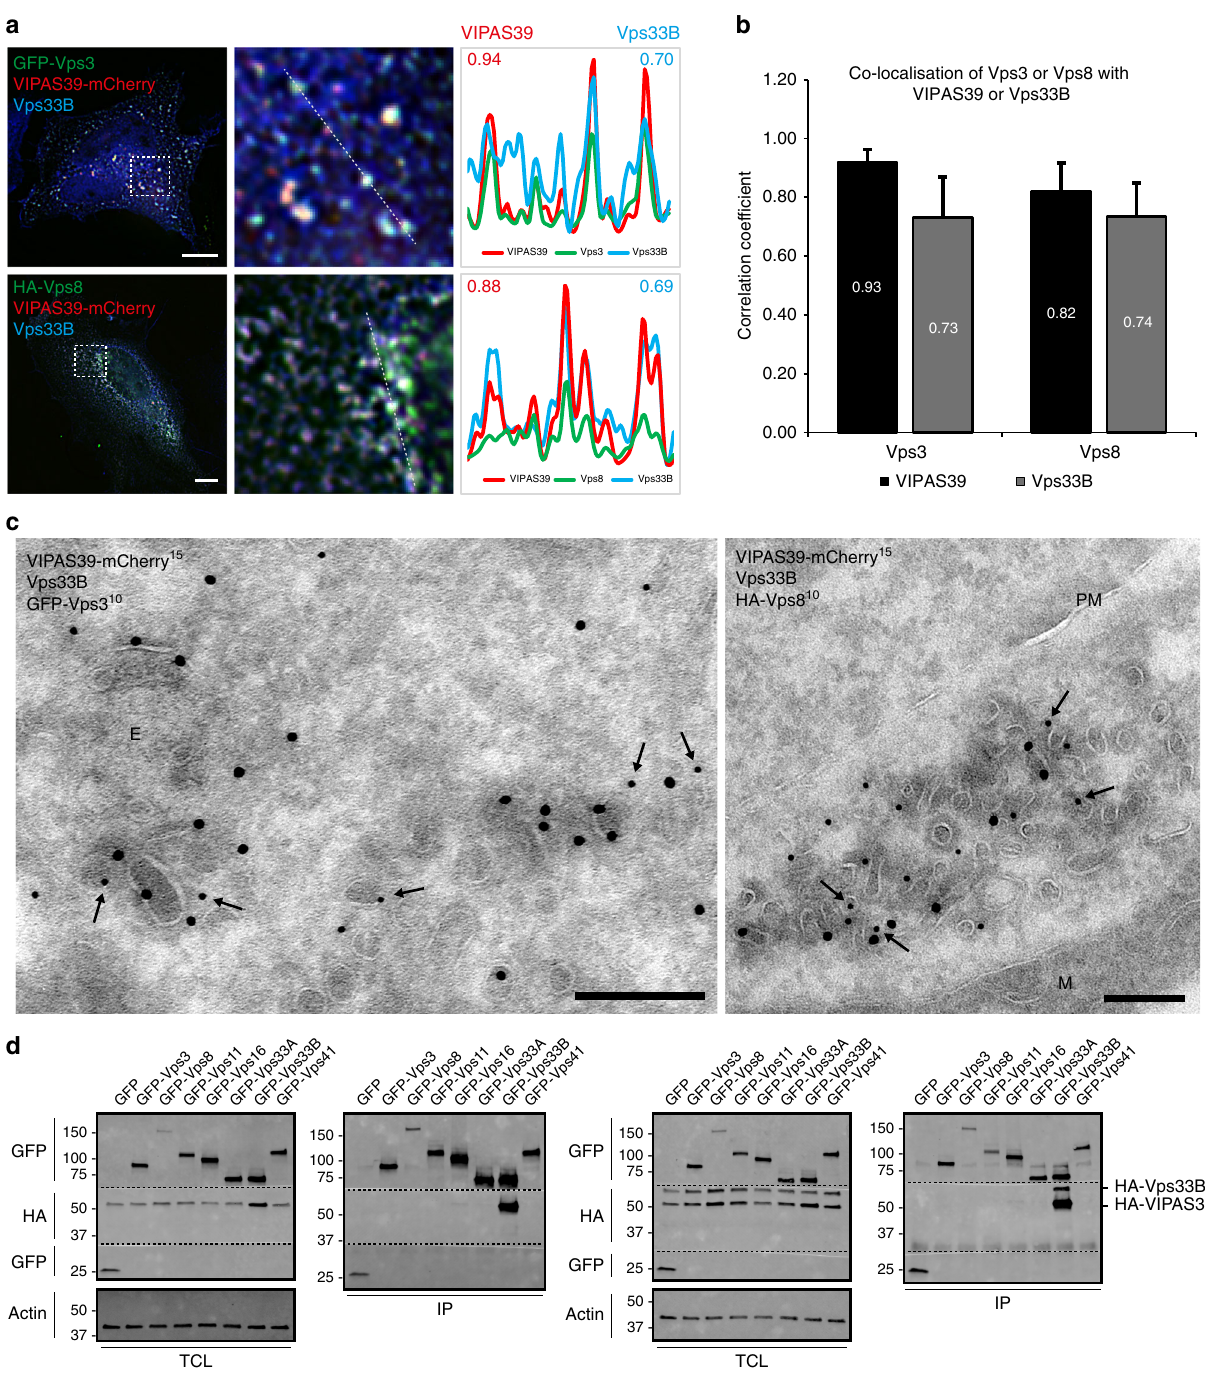
Fig. 3 Vps3 and Vps8 co-localise with the CHEVI complex. a IF of HeLa cells expressing VIPAS39-mCherry, untagged Vps33B and either GFP-Vps3 or HA- Vps8. Vps3 and Vps8 co-localise with both VIPAS39 and Vps33B (line pro fi les in right panel indicate co-localisation correlation, correlation coef fi cients indicated: VIPAS39 = red; Vps33B = blue). Bar, 10 µ m. b Quanti fi cation of triplicate experiments shown in a based on n > 30 cells per condition by line pro fi le correlations. The mean is calculated using Fishers ’ r to z transformation. Error bars represent SEr, calculated using Eqs. 4 and 5. c IEM analysis of HeLa cells expressing VIPAS39-mCherry (15 nm gold), untagged Vps33B (not labelled) and either GFP-Vps3 (10 nm gold, arrows) or HA-Vps8 (10 nm gold, arrows). Vps3 (left panel) and Vps8 (right panel) co-localise with VIPAS39 on recycling vesicles and tubules. E endosome, M mitochondria, PM plasma membrane. Bar, 200 nm. d IPs of GFP, GFP-tagged Vps3, Vps8, Vps11, Vps16, Vps33A, Vps33B or Vps41 probed for interaction with co-expressed HA-VIPAS39 (left panel) or with co-expressed HA-VIPAS39 and HA-Vps33B (right panel) in HeLa cells. Only Vps33B shows a strong interaction with